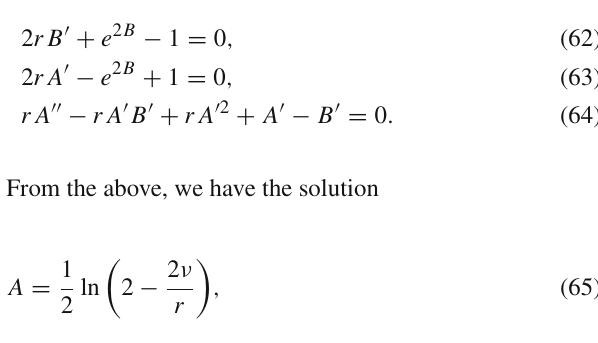
G. Substituting c 14 = 0 into the field Eqs. (20)–(22), we